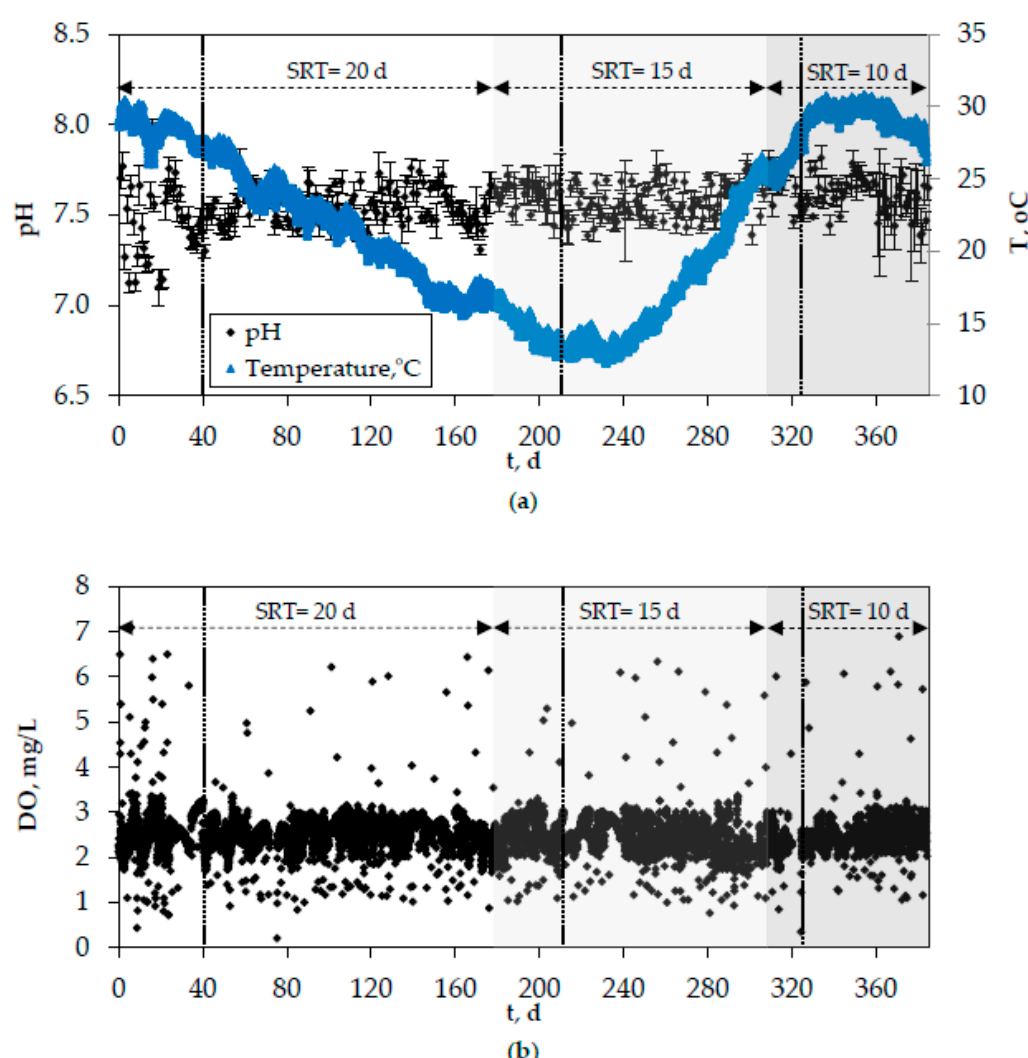
Figure 10. Evolution of (a) pH, temperature, and (b) dissolved oxygen (DO) concentration in the biomass of the lab-scale MBR.